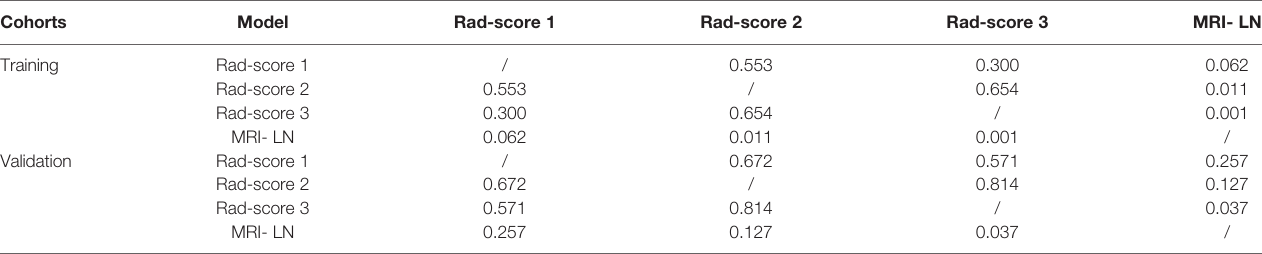
TABLE 3 | Comparison of AUCs among models.